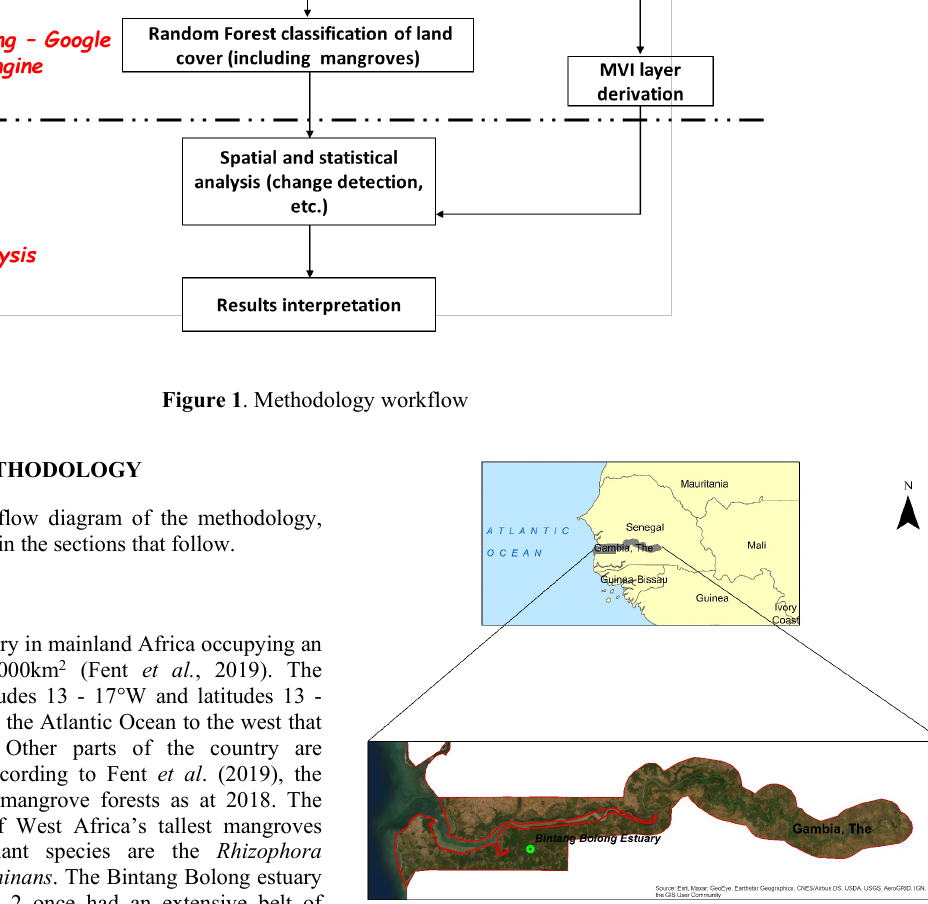
Figure 2 . Map of the study area.